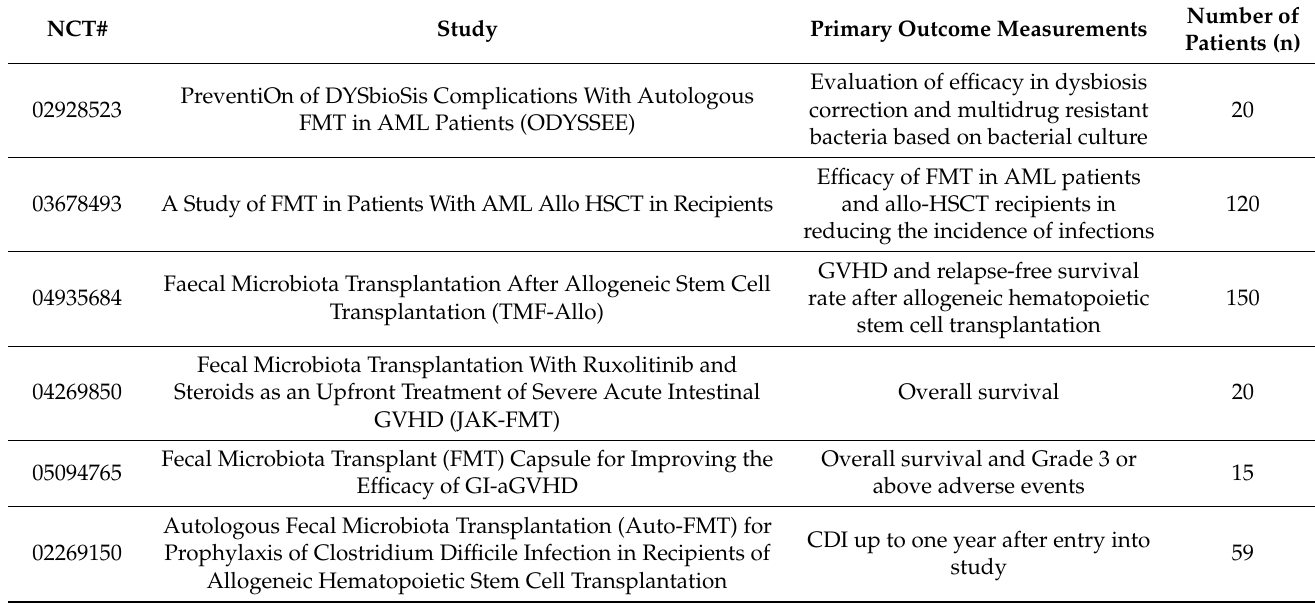
Table 3. Clinical studies registered in Clinicaltrials.gov for hematologic and oncologic patients in the US and in